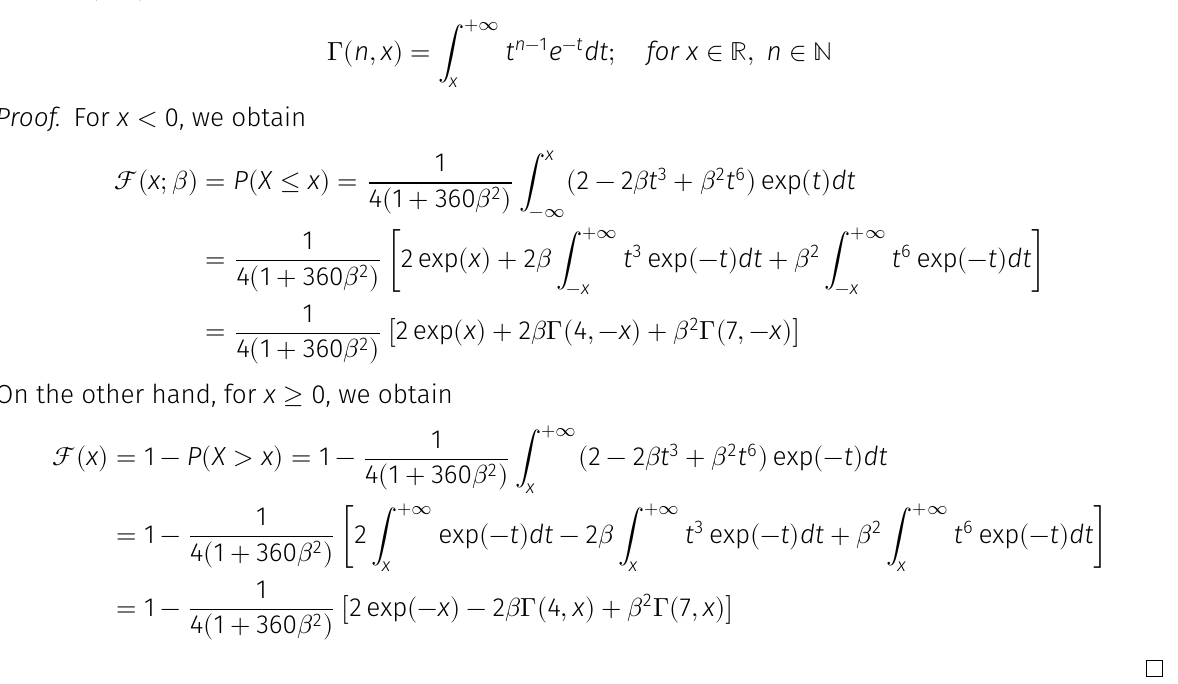
Figure 2. The graphs of skewness (on the left) and kurtosis (on the right) of BSL (𝜷) as function of 𝜷 . where Γ( n , x ) is the upper incomplete gamma function defined